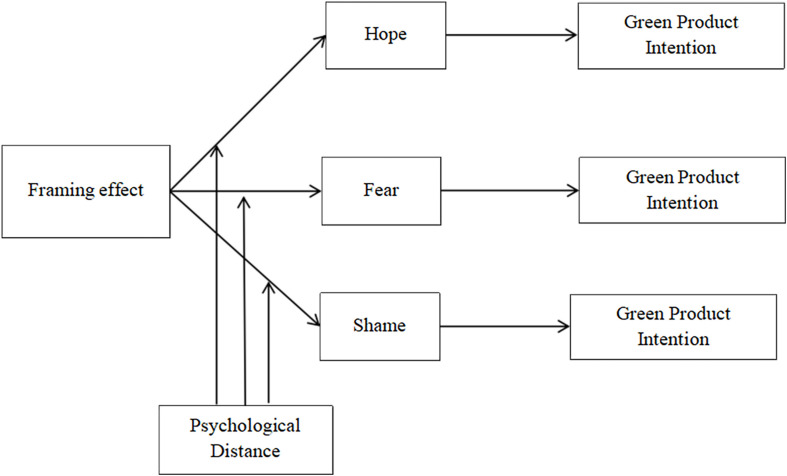
Model of full Study.